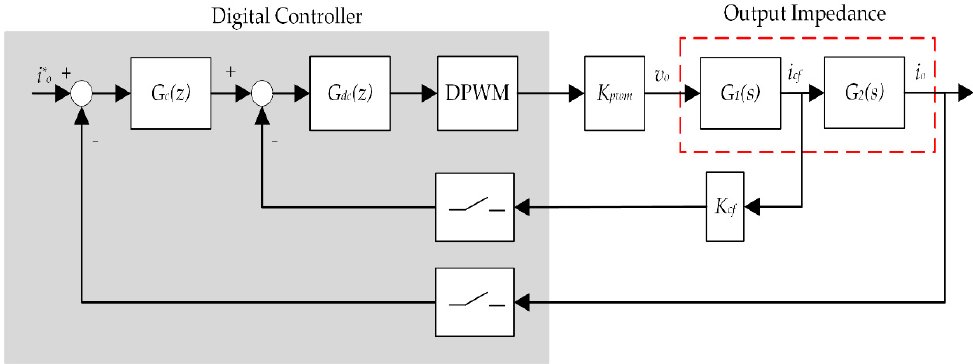
Figure 6. Digital control model of the output current controller.